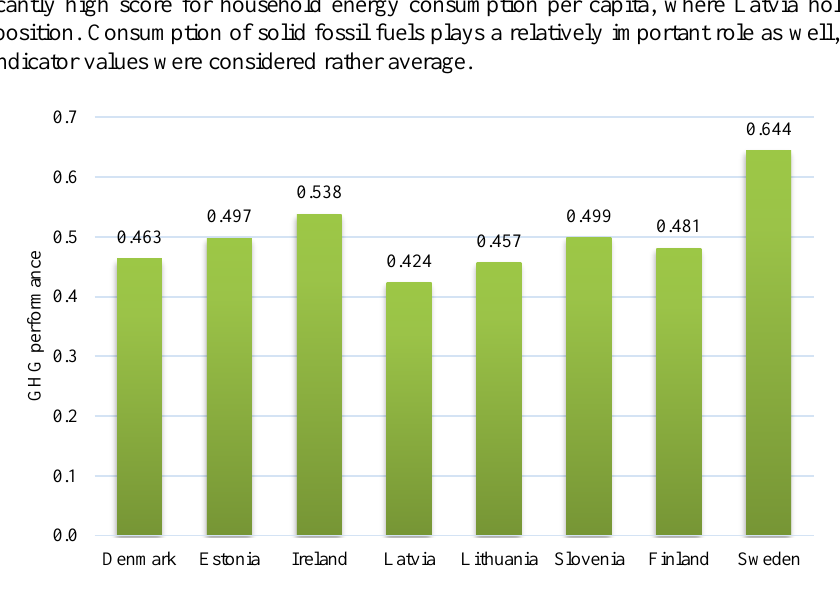
Fig. 4. Ranking of countries’ GHG